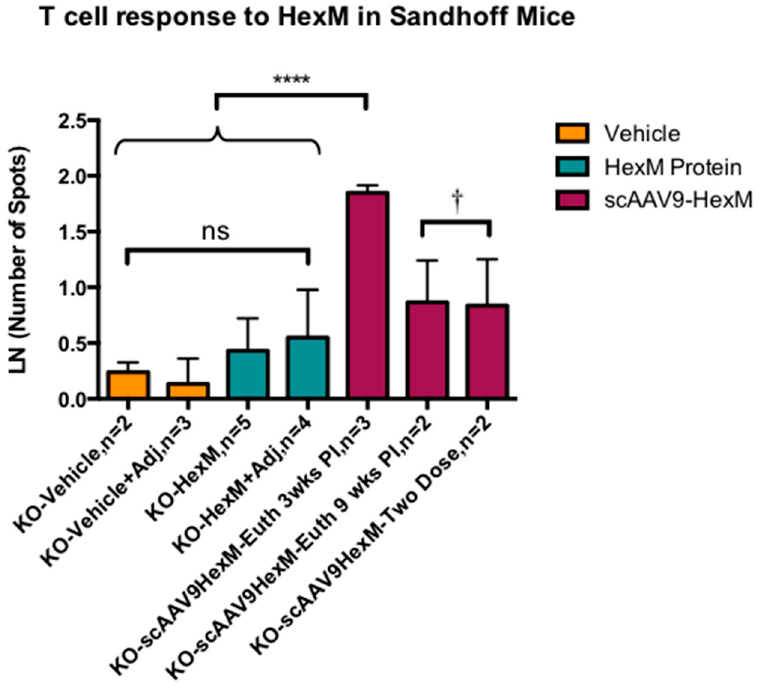
Figure 2. HexM ‐ specific T cell response in SD mice. ELISPot IFN ‐γ secretion in response to HexM stimulated splenocytes of SD mice 3 weeks and 9 weeks post injection. Mice receiving scAAV9